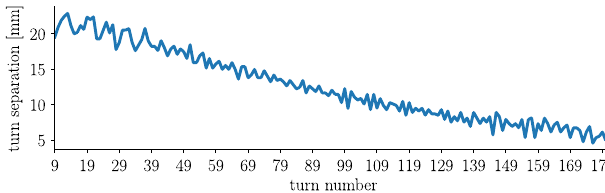
FIG. 8. Measurement of the beam phase φ shift due to trim coils